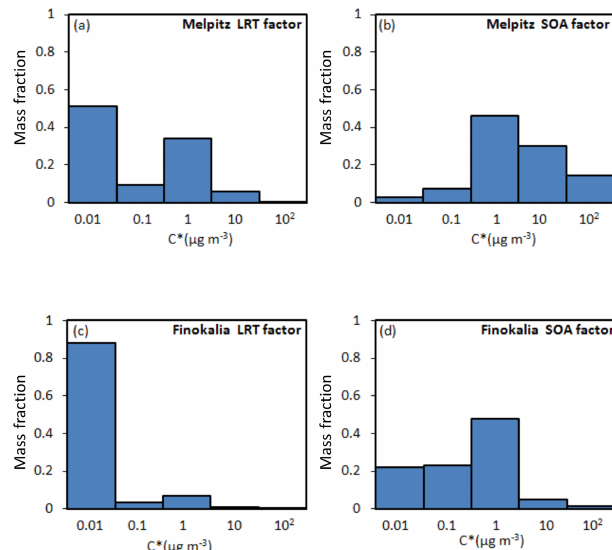
Figure 9. Volatility distribution of the (a) LRT factor in Melpitz, (b) SOA factor in Melpitz, (c) LRT factor in Finokalia, and (d) SOA factor in Finokalia.